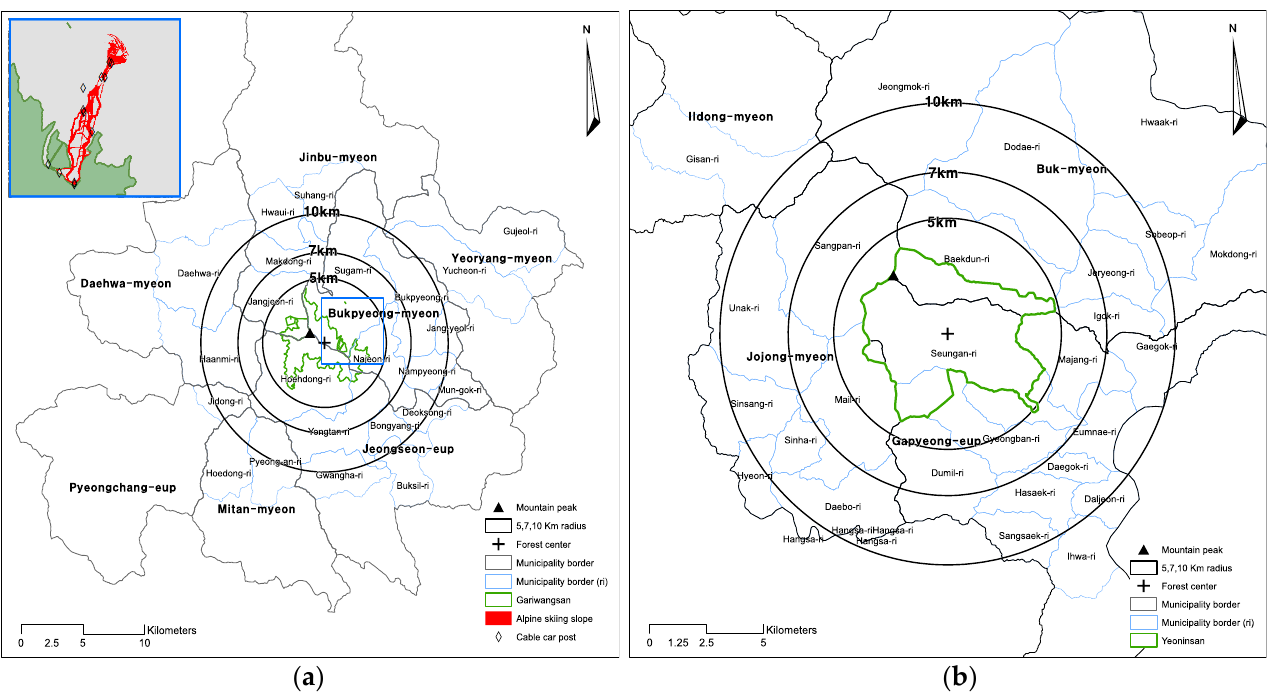
Figure 1. Study areas: ( a ) Gariwangsan and ( b ) Yeoninsan with shaded relief as the background.